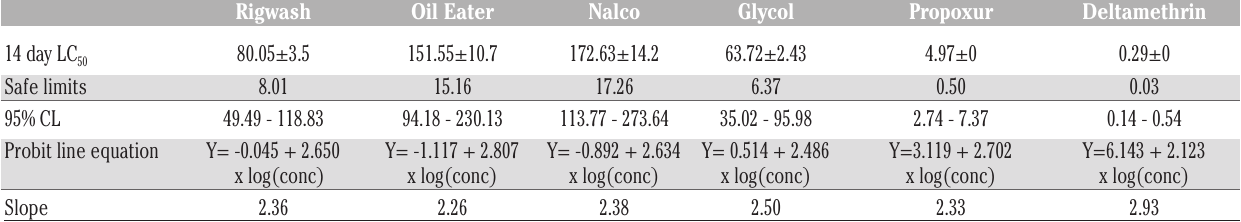
Table 2. Acute toxicity profile of earthworm ( Aporrectodea longa ) exposed to the test chemicals at day